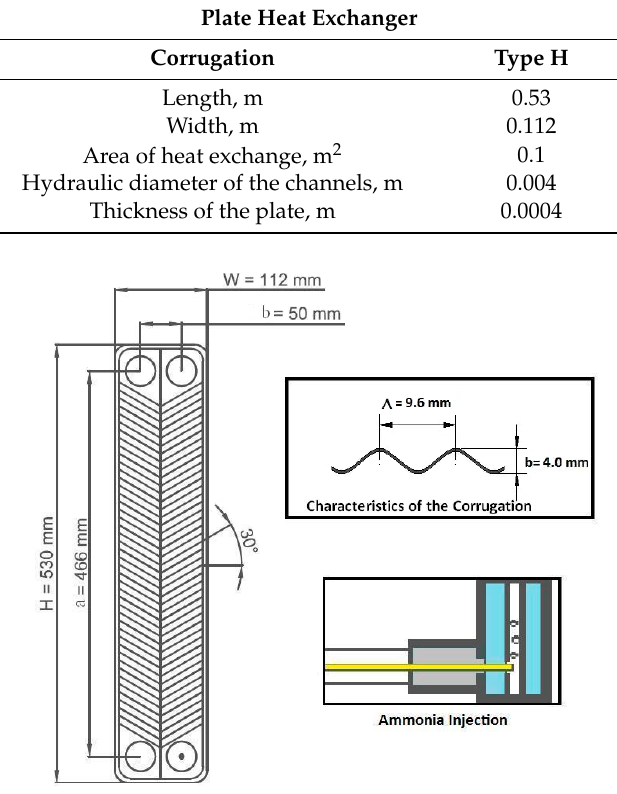
Figure 2. Main details of the H-type PHE.